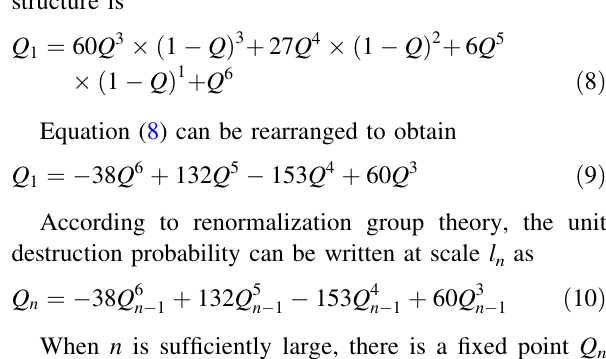
(a) Regular tetrahedron